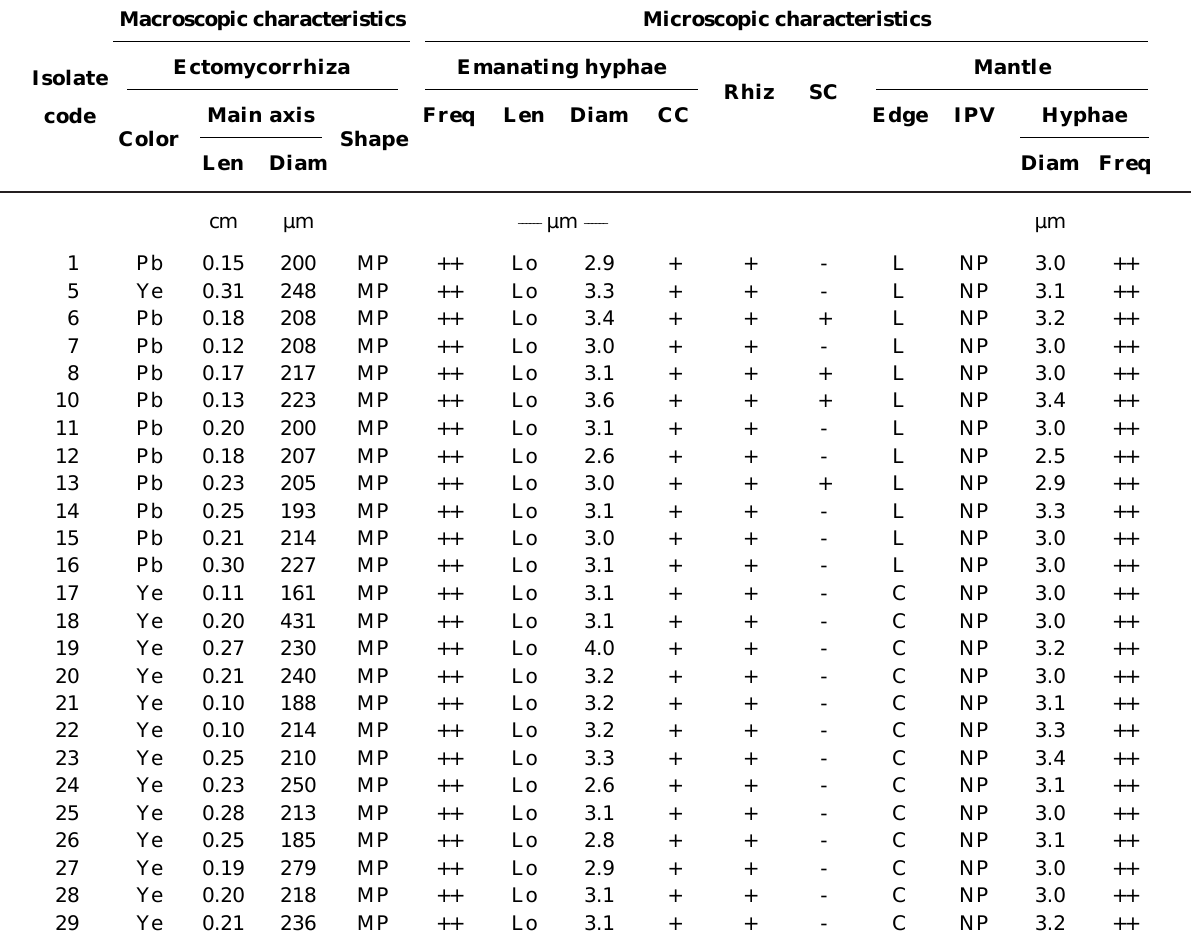
Table 2. Macroscopic and microscopic characteristics of ectomycorrhizae formed on Eucalyptus grandis by Pisolithus sp. isolates, 110d after cultivation under greenhouse